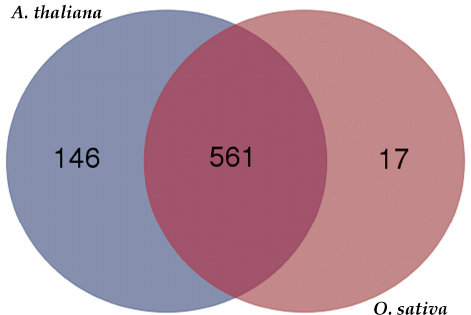
Figure 5. Conservation analysis of significantly changed phosphoproteins in J. curcas seedling under different treatment.